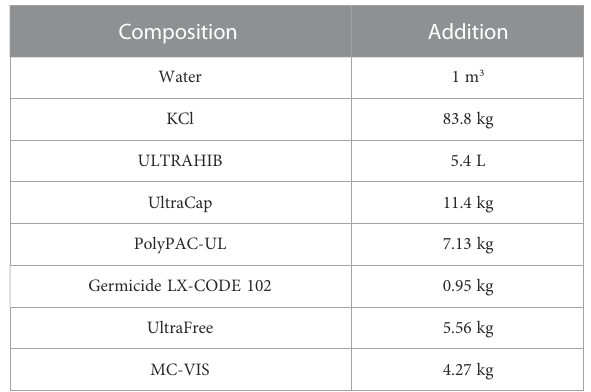
TABLE 1 Formulation of